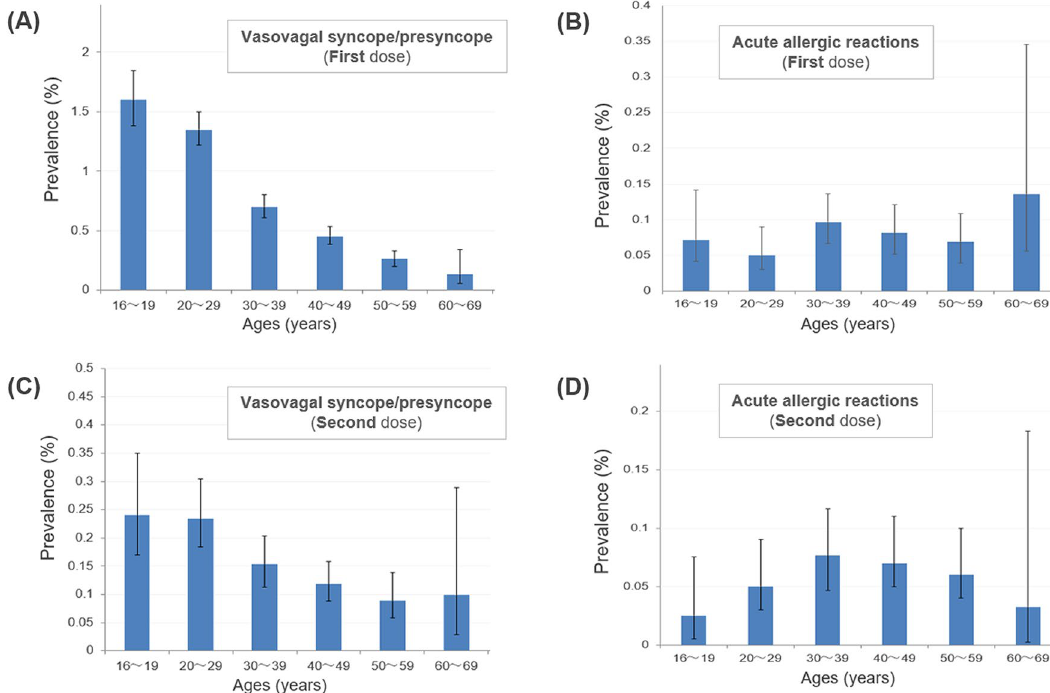
Figure 2. Occurrence rate of acute adverse events by age group. The prevalence and 95% confidence interval of acute adverse events (vasovagal syncope/presyncope or acute allergic reaction) after the first vaccine dose ( A , B ) and after the second vaccine dose ( C , D ) in different age groups are shown. The occurrence of vasovagal syncope/presyncope was most likely to occur in younger populations of those aged 16–29 years, whereas the